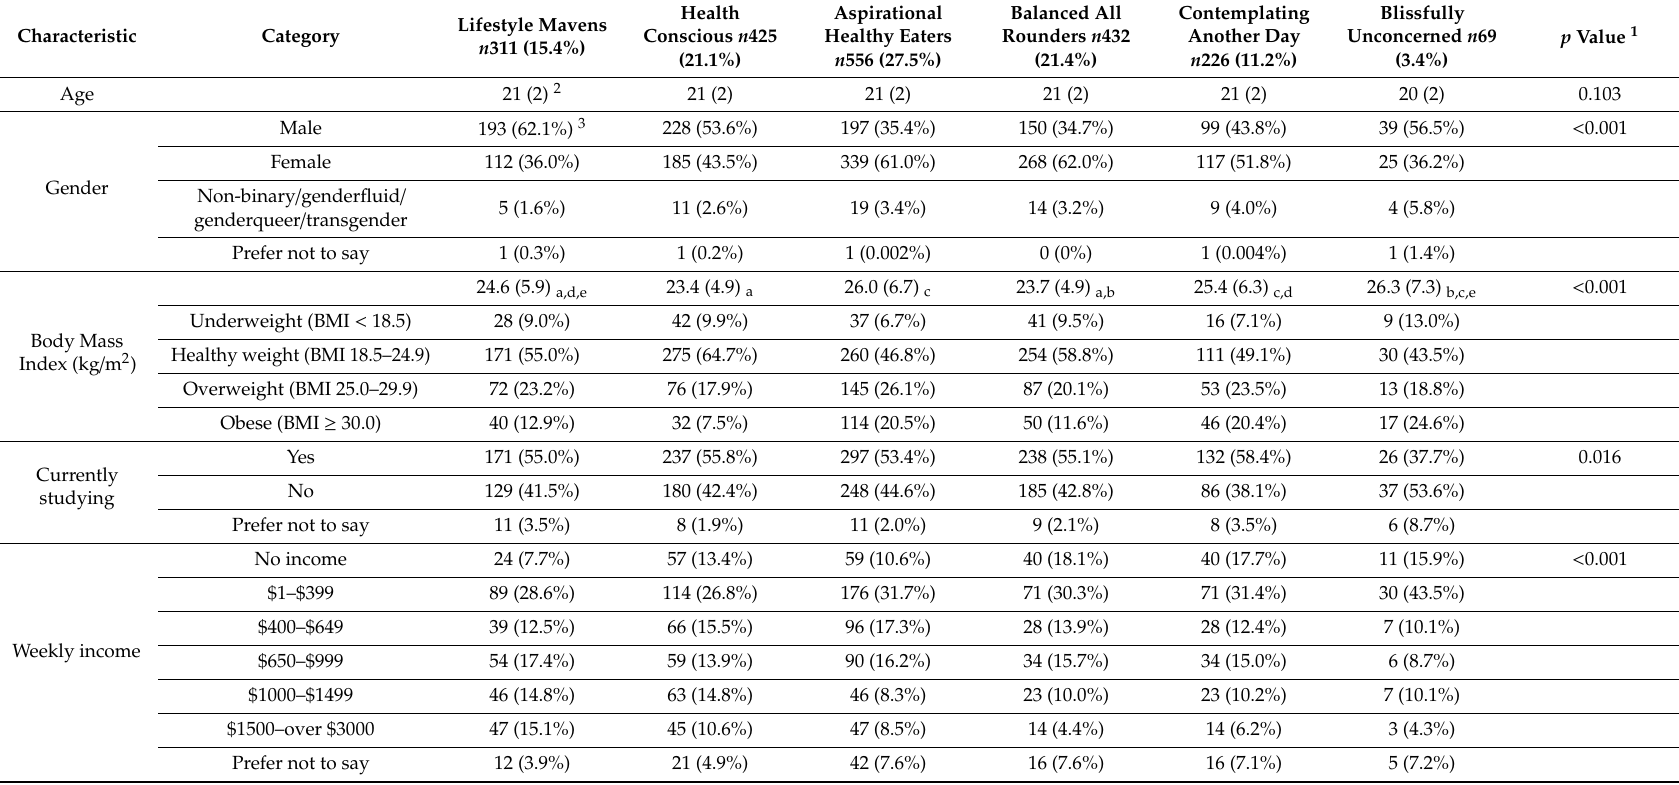
Table 4. Participant characteristics of online survey assessing Living and Eating for Health Segments ( n =